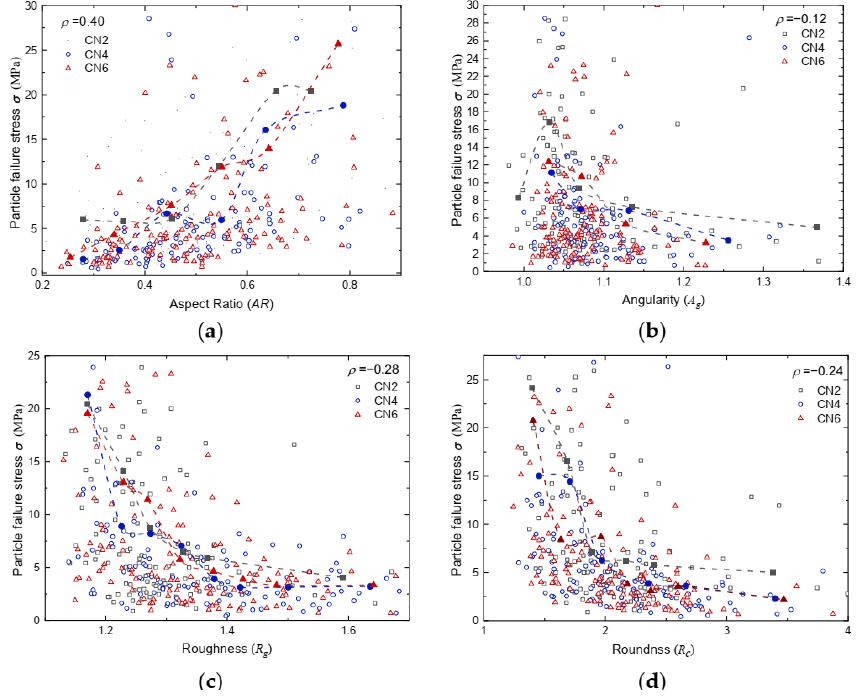
Figure 11. ( a ) The effect of aspect ratio on failure stress; ( b ) the effect of angularity on failure stress; ( c ) the effect of roughness on failure stress; ( d ) the effect of roundness on failure